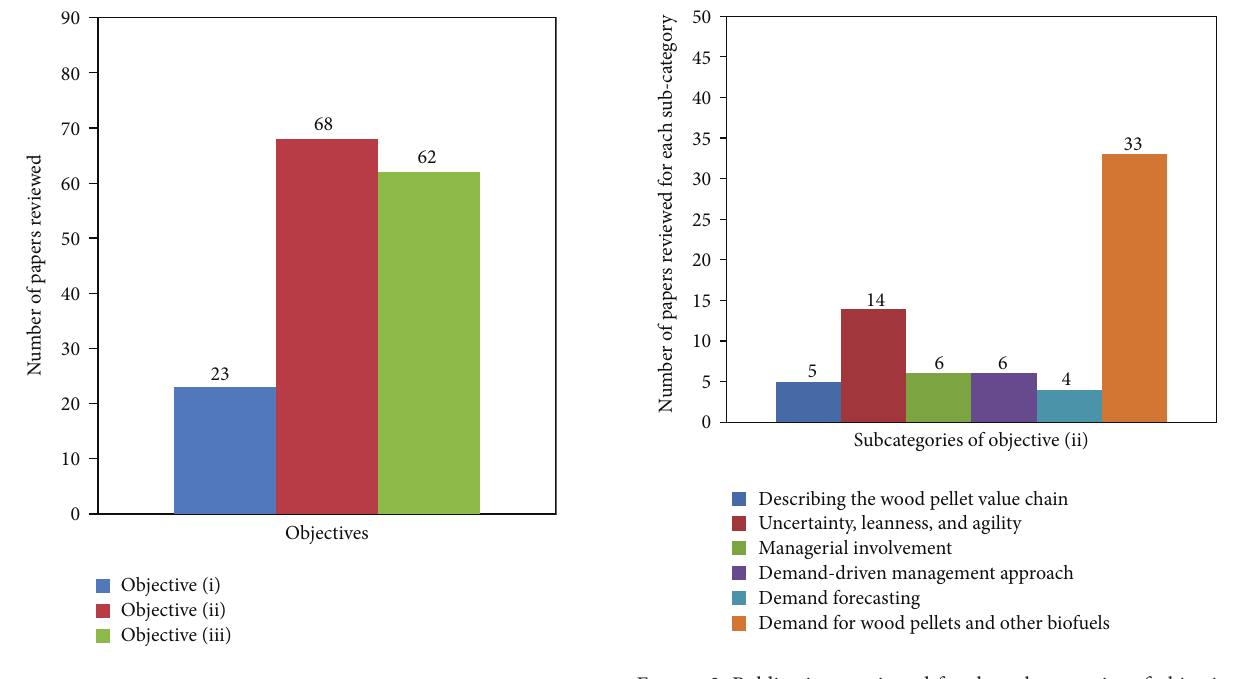
Figure 1: Total publications reviewed for objectives (i), (ii), and (iii).